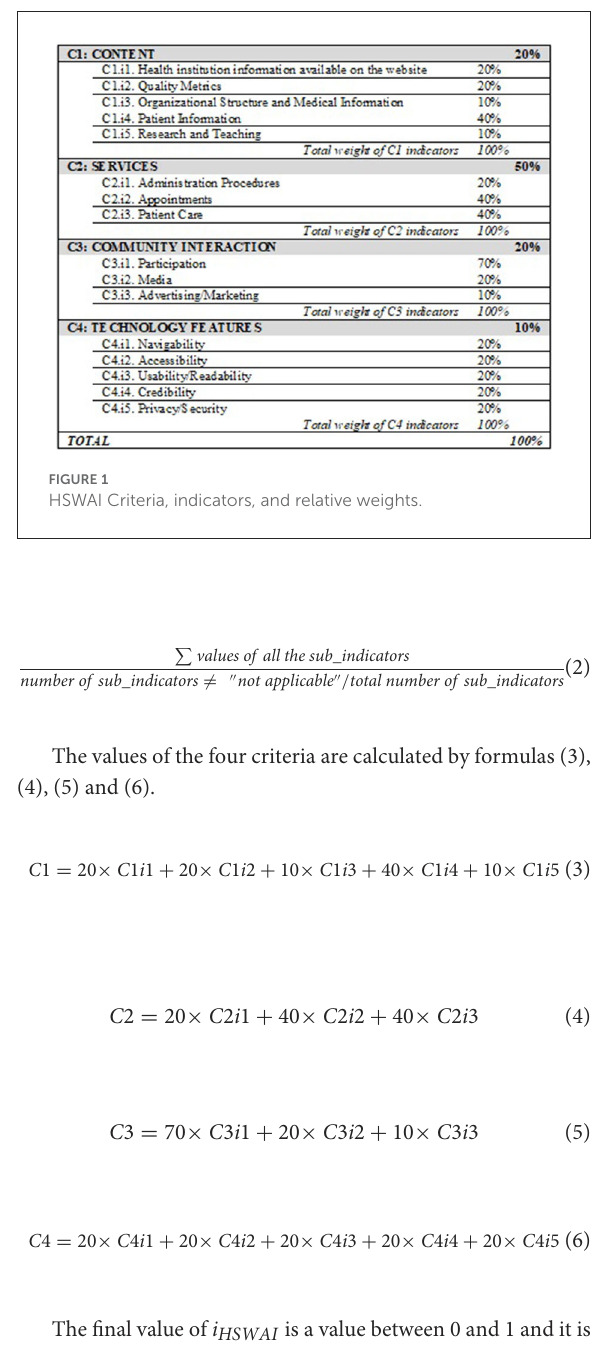
FIGURE1 HSWAI Criteria, indicators, and relative weights.